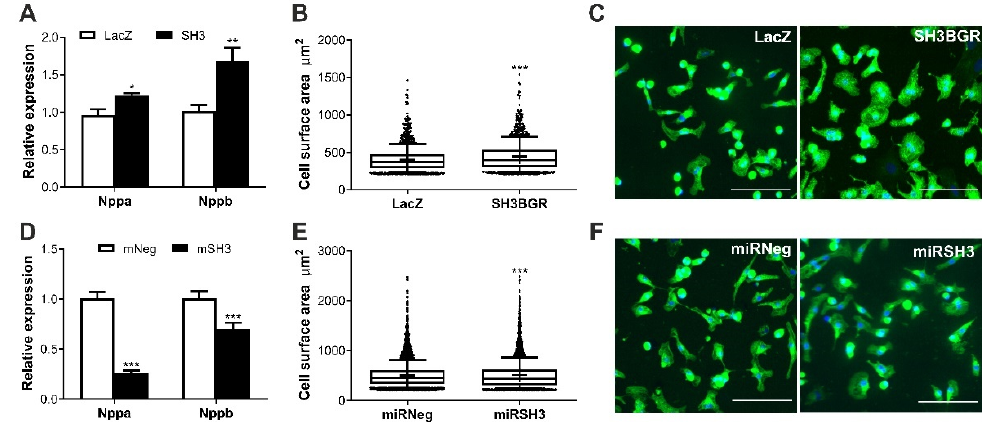
Figure 2. Effect of SH3BGR ablation on hypertrophy in vitro. ( A ) Overexpression of SH3BGR in NRVCMs upregulated fetal genes Nppa and Nppb compared to LacZ control ( n = 3). ( B ) In line with these results, an increase in cell surface area of NRVCMs was also observed as seen in ( B ); representative images are depicted in ( C ). Contrastingly, on SH3BGR knockdown, this hypertrophic induction was abrogated observed by downregulation of hypertrophic markers ( D ) and reduced cell surface area ( E , F ) in miRSH3 condition as compared to miRNeg. Statistical calculations were carried out using the Student’s t -test. *, p < 0.05; **, p < 0.01; ***, p < 0.001; SH3, SH3BGR; miRSH3, miRSH3BGR; Nppa, natriuretic peptide A; Nppb, natriuretic peptide